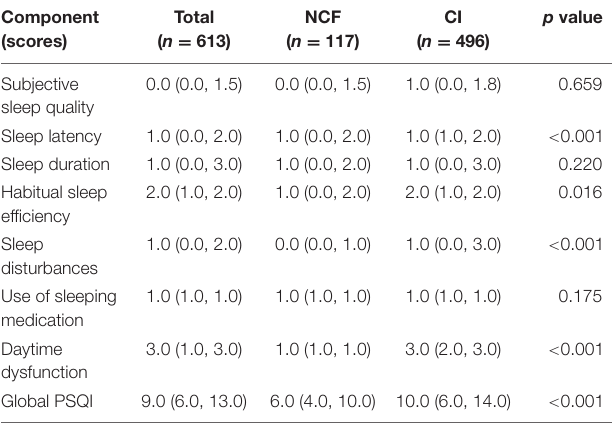
TABLE 2 | Global and seven component scores of PSQI, in HD patients with NCF and